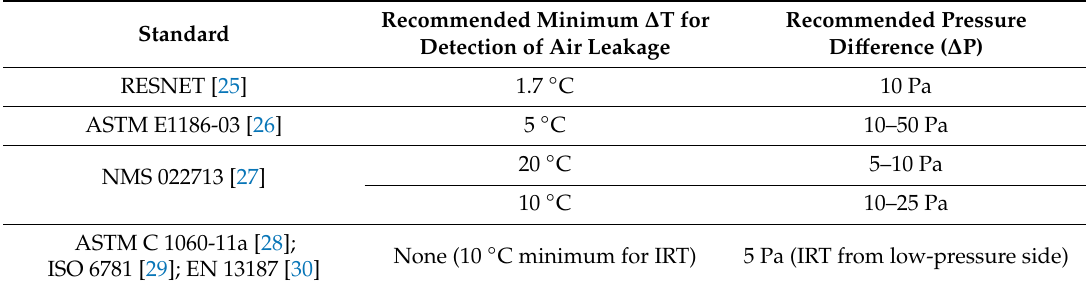
Table 1. Recommended temperature and pressure di ff erences for detection of air leakage with infrared thermography